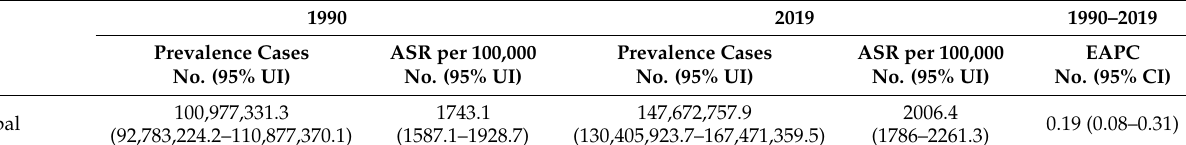
Table 1. The prevalence cases and age-standardized prevalence of PEM in 1990 and 2019, and its temporal trends from